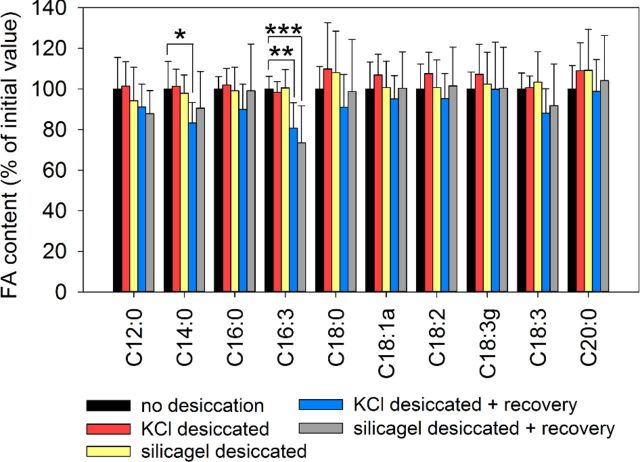
Fatty acid content in different experimental treatments relative to non-desiccated control. Only data for the most abundant fatty acids are shown. As two-way ANOVA did not reveal any significant interaction between strain and treatment, data for both strains were analyzed together (mean +SD, n = 10). Significant differences from the initial value (no desiccation) are marked by asterisks (P < 0.001***, 0.001 < P < 0.01**, 0.01 < P < 0.05*, Dunnett's test).